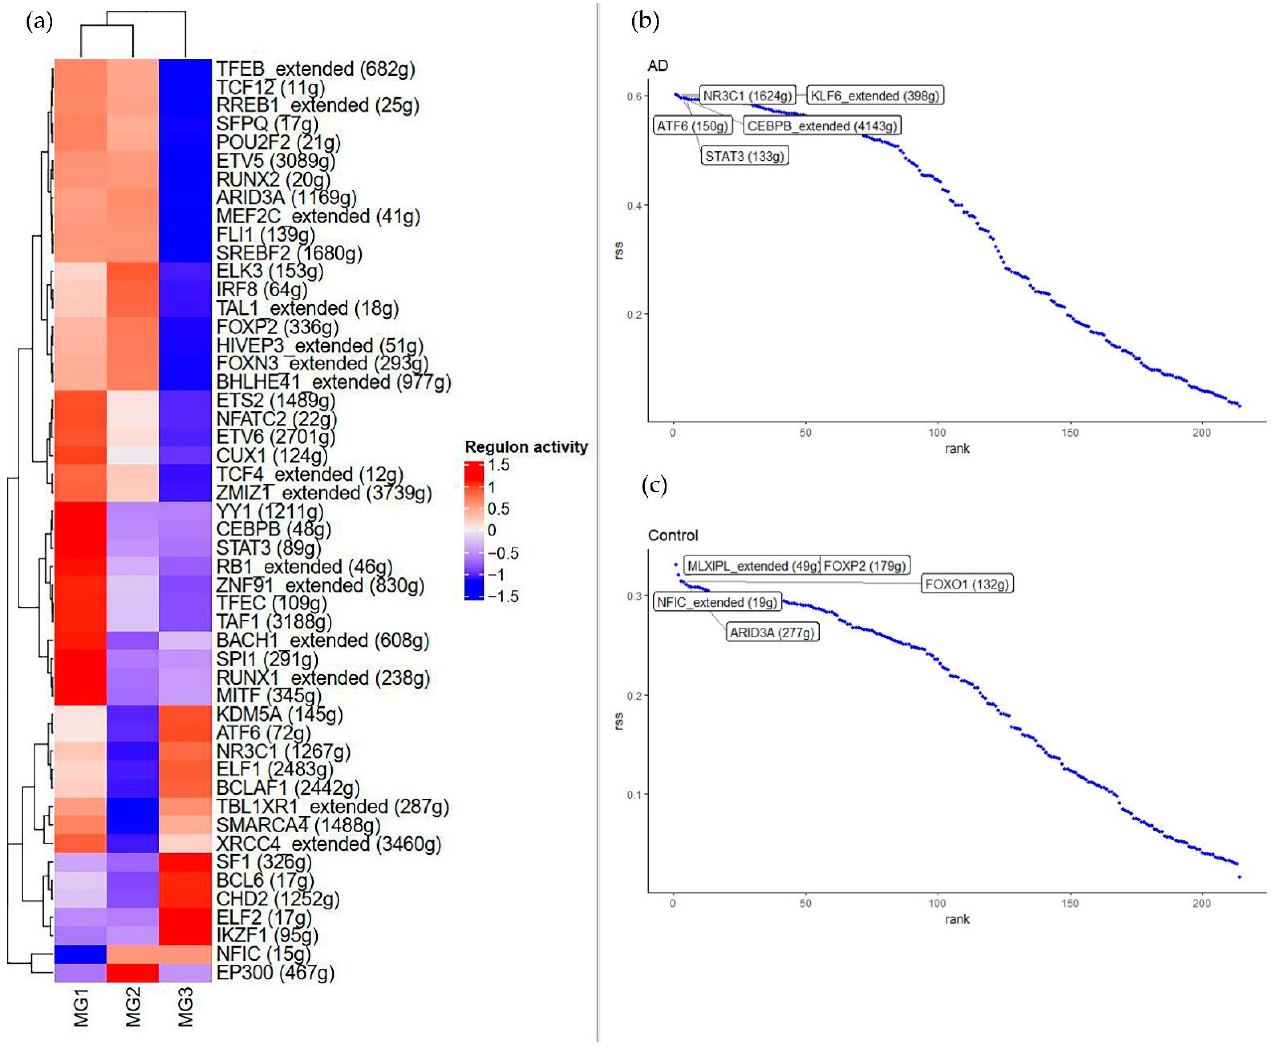
Figure 3. Regulators of differences in MG. ( a ) Heat map of regulator activity, showing the difference in regulator activity between the microglia subpopulations, with negative correlations in blue and positive correlations in red. The values range from − 1.5 to 1.5. “Extended” indicates the activity between TFs and all target genes. “No extended” indicates activity between TFs and high-confidence target genes. ( b , c ) Ranking of MG1 cluster regulators in AD and normal samples, using the RSS specificity score. “E xtended ” indicates the activity between TFs and all target genes. ( b , c ) are the top 5 specific regulators in AD and Control, respectively.